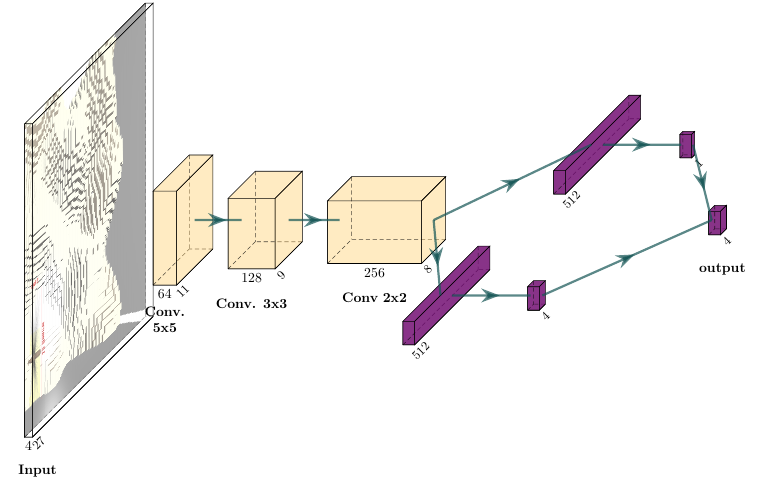
Figure 11. Network structure for the DDDQN